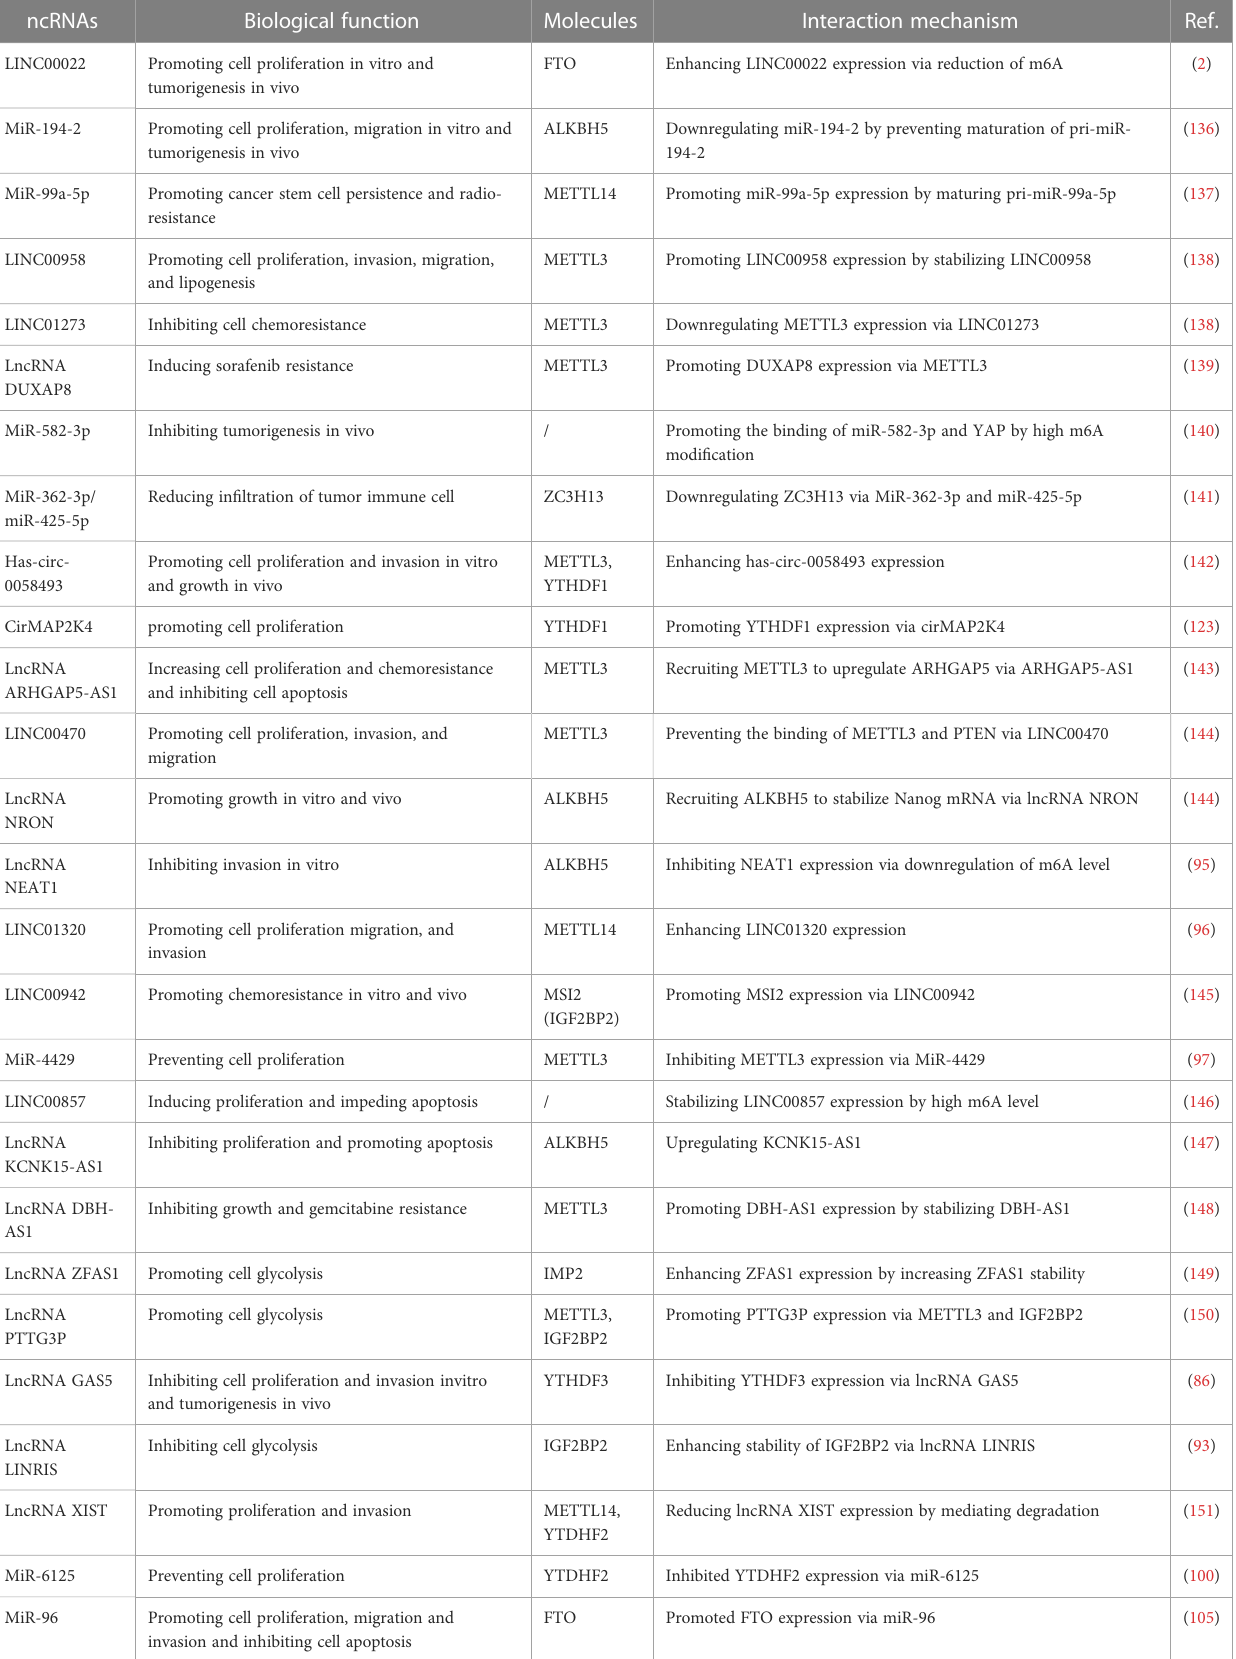
TABLE 1 Mechanism of interaction between main ncRNAs and m6A in gastrointestinal